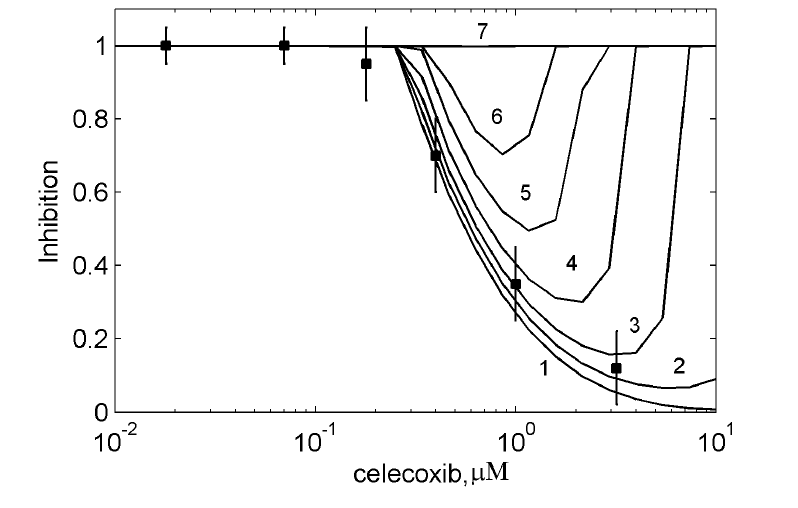
Figure 10. Effect of the suppression of aspirin-mediated inhibition of platelet PGHS-1 by celecoxib. The theoretical dependencies of platelet PGHS-1 inhibition on celecoxib concentration calculated at the partial removal of celecoxib after preincubation. Line 1—100% removal of celecoxib, line 2—70%, line 3—50%, line 4—30%, line 5—20%, line 6—10%, line 7—no removal of celecoxib. Lines—theoretical results on inhibition of PGH production, points—experimental data on inhibition of TXB 2 production by platelets washed after preincubation [8]. Inhibition is given in relative units. Aspirin concentration—100 µ